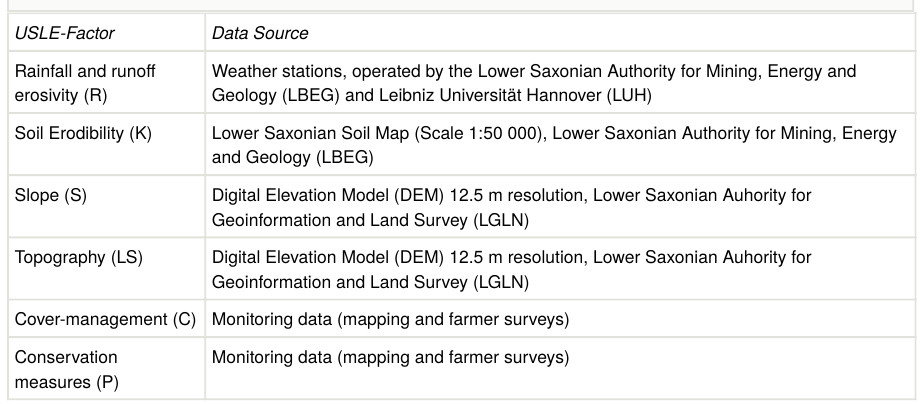
and A represent the mean annual soil loss rate [t ha a ], R the rainfall intensity [N ha a ], K the soil erodibility [t h ha N ] and S [dimensionless] the slope factor. In the formula for the actual soil loss rate, the slope factor S is extended to the topography factor LS (length and slope) [dimensionless]. The factors C [dimensionless] and P [dimensionless] re fl ect the e ff ects of management and conservation measures. Table 2 lists the data sources used for calculation of the factors. Table 2. Origin of data used in USLE-Factor Data Source Rainfall and runo ff Weather stations, operated by the Lower Saxonian Authority for Mining, Energy and erosivity (R) Geology (LBEG) and Leibniz Universität Hannover (LUH) Soil Erodibility (K) Lower Saxonian Soil Map (Scale 1:50 000), Lower Saxonian Authority for Mining, Energy and Geology (LBEG) Slope (S)